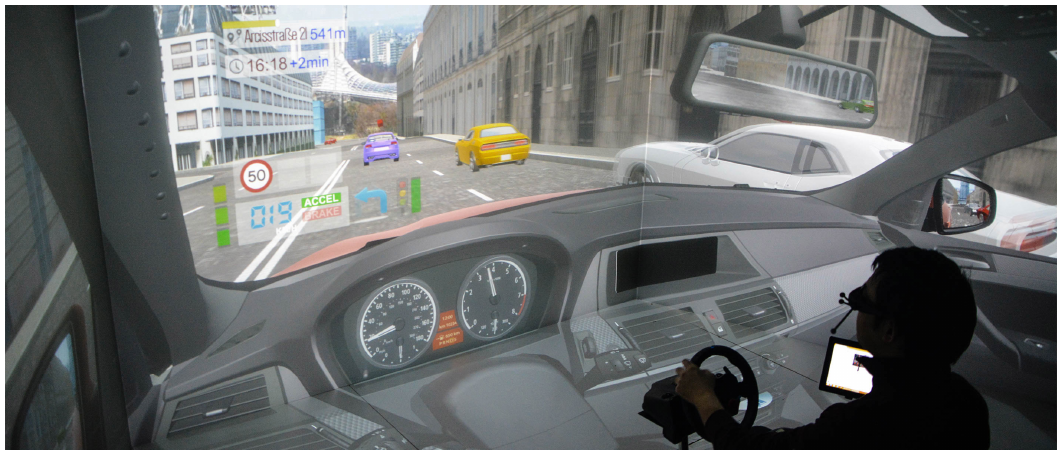
Figure 4. The basic study setup of our driving simulation in the MR environment. The driver is seated in front of the (ineffective) steering wheel. Rendered in 2D for better visibility, best viewed in